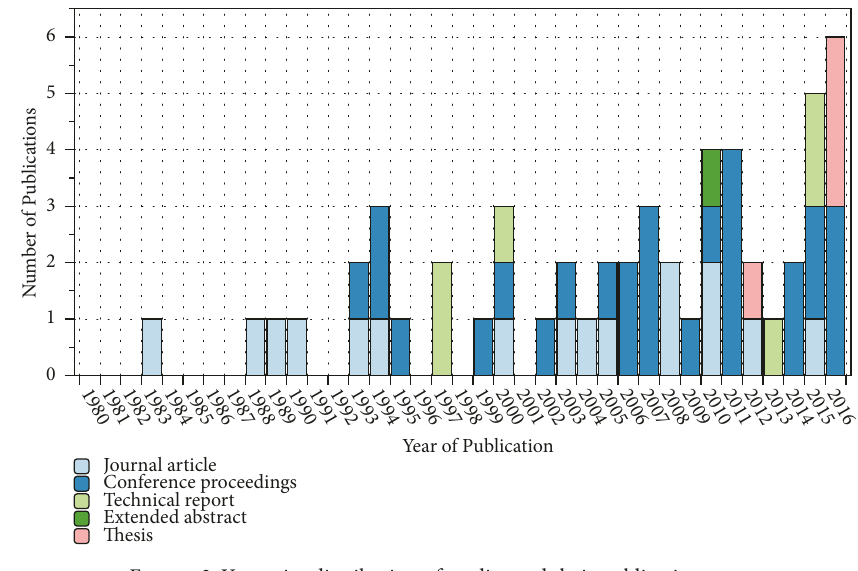
Figure 3: Year-wise distribution of studies and their publication type. Table 7: Summary of top publications for KLM